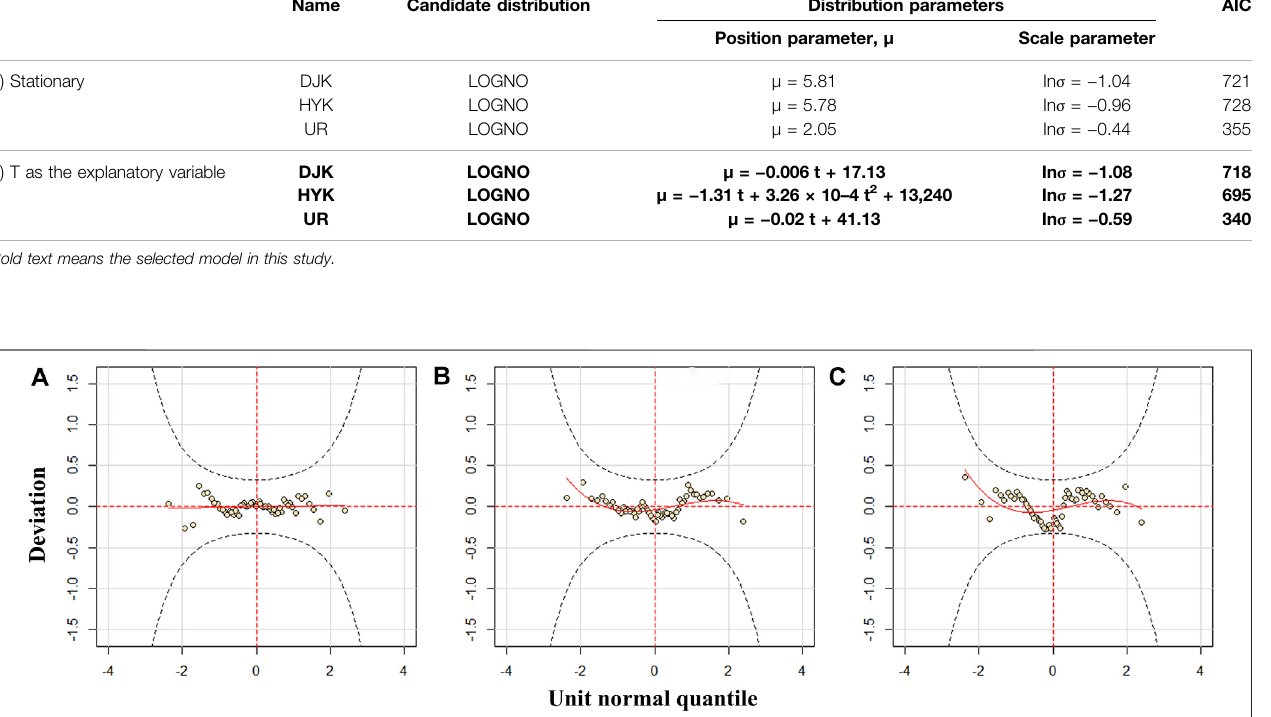
FIGURE 4 | Worm plot of the residuals by GAMLSS for annual runoff series at (A) DJK, (B) HYK, and (C) UR.